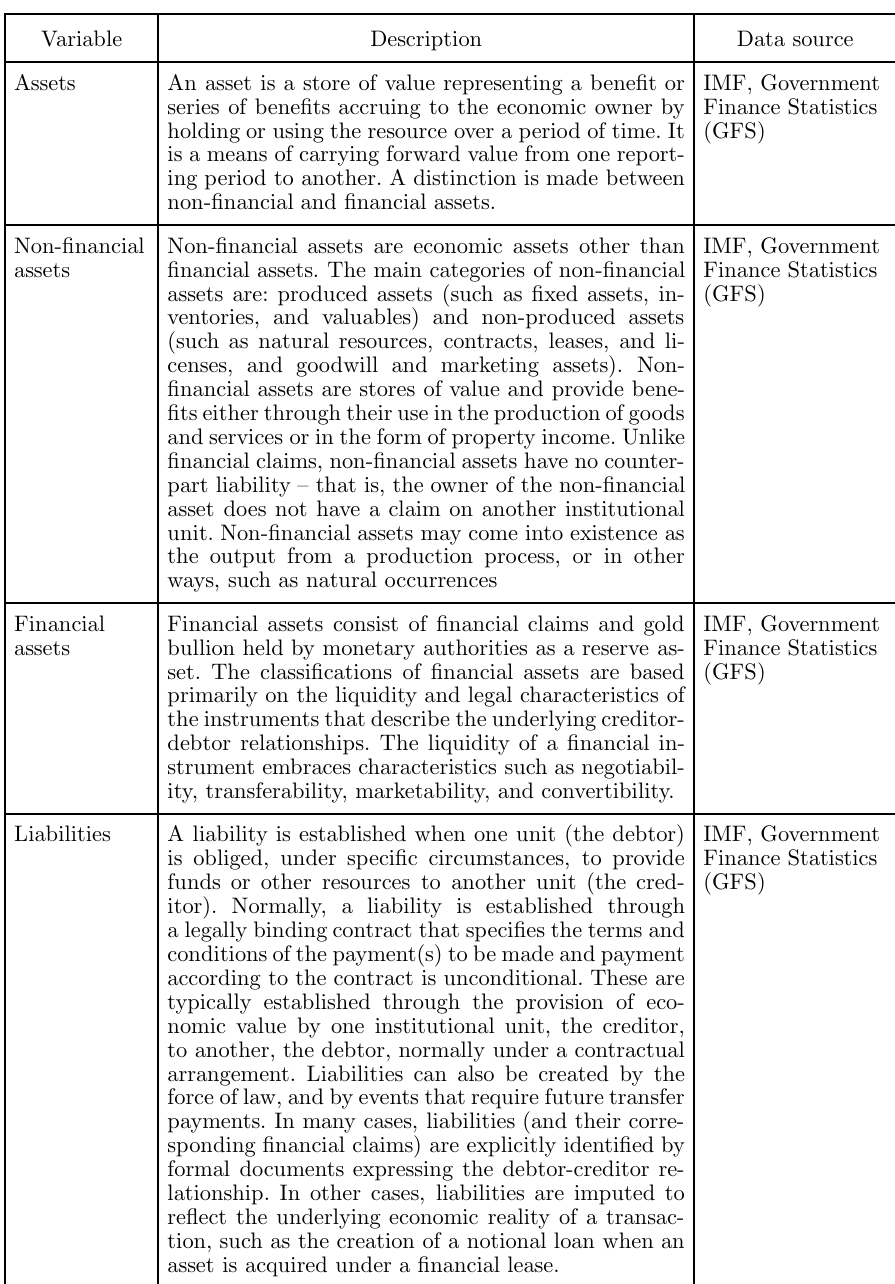
List and description of variables with